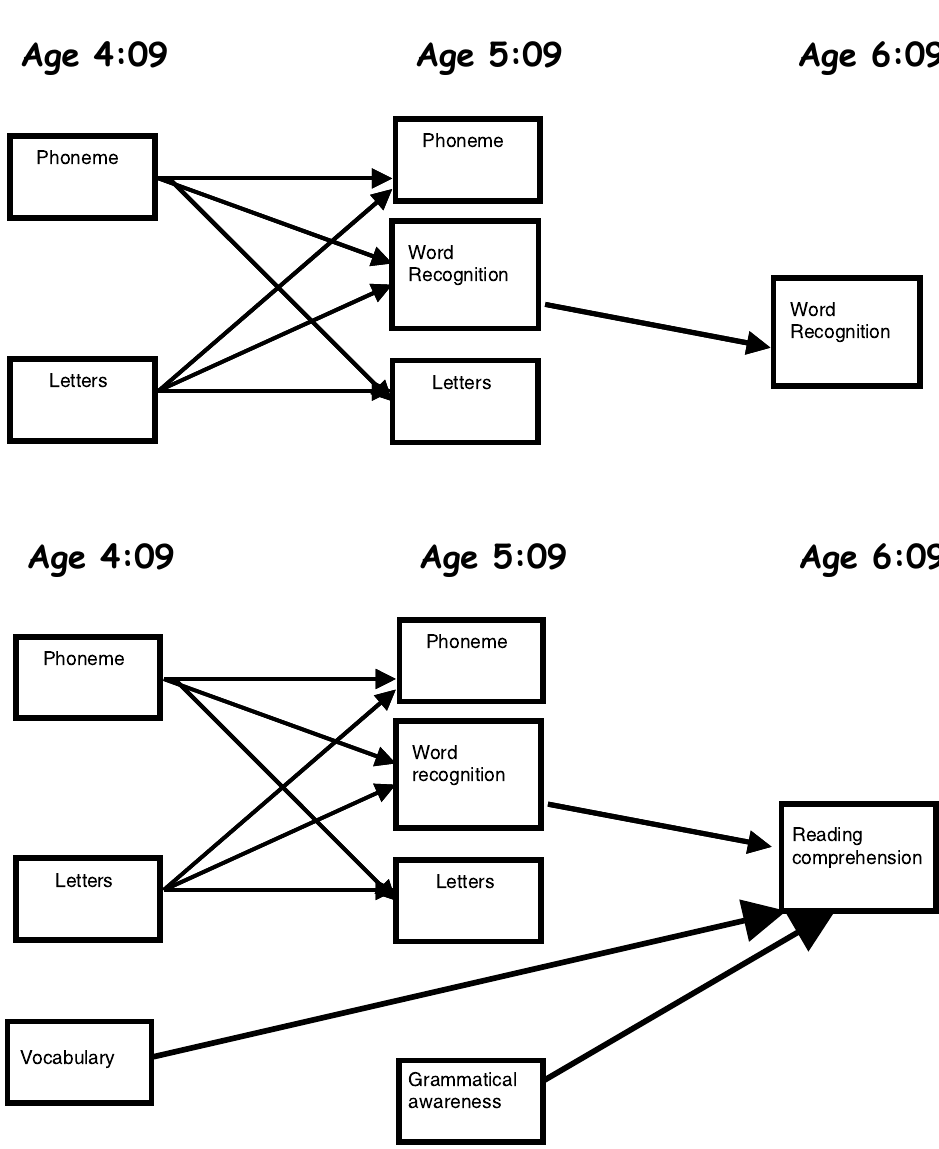
Figure 2. Path diagrams showing (a) the relationships between pre-school phonological awareness and later word recognition skills; and (b) the relationships between pre-school vocabulary, early grammatical awareness and later reading comprehension skills (after Muter et al., in